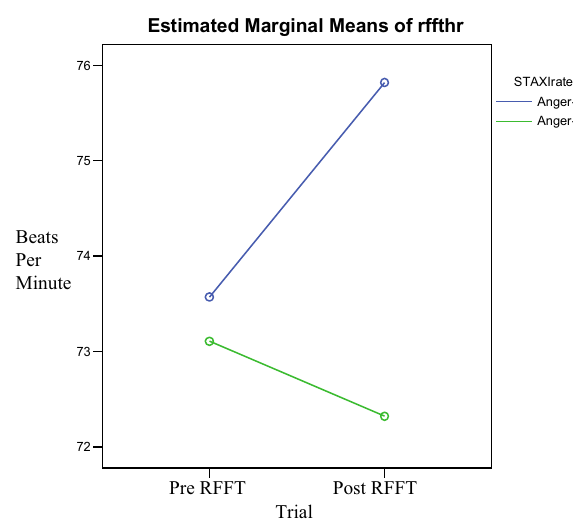
Fig. 4 RFFT heart rate, group by time